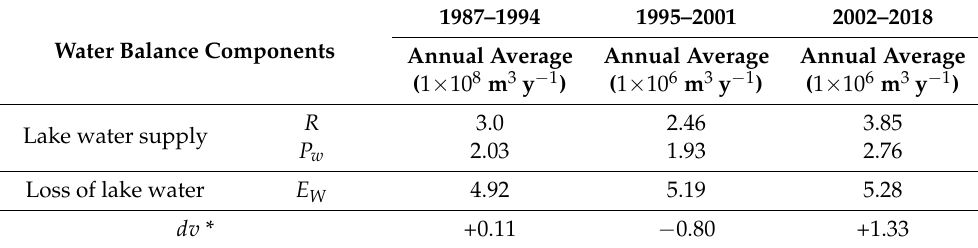
Table 1. The Hala Lake water balance from 1987 to 2018.